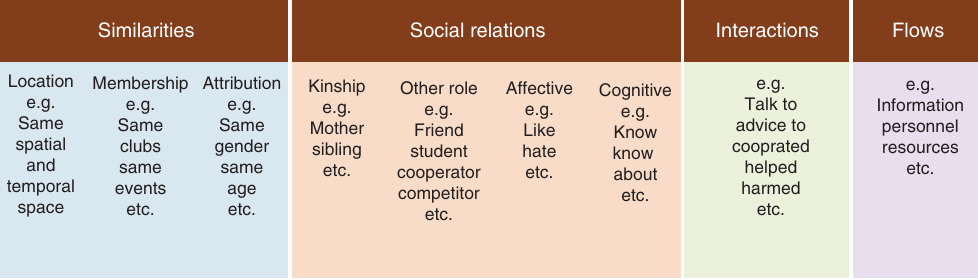
Figure 1: Typology of Types of Ties Among Persons in Social